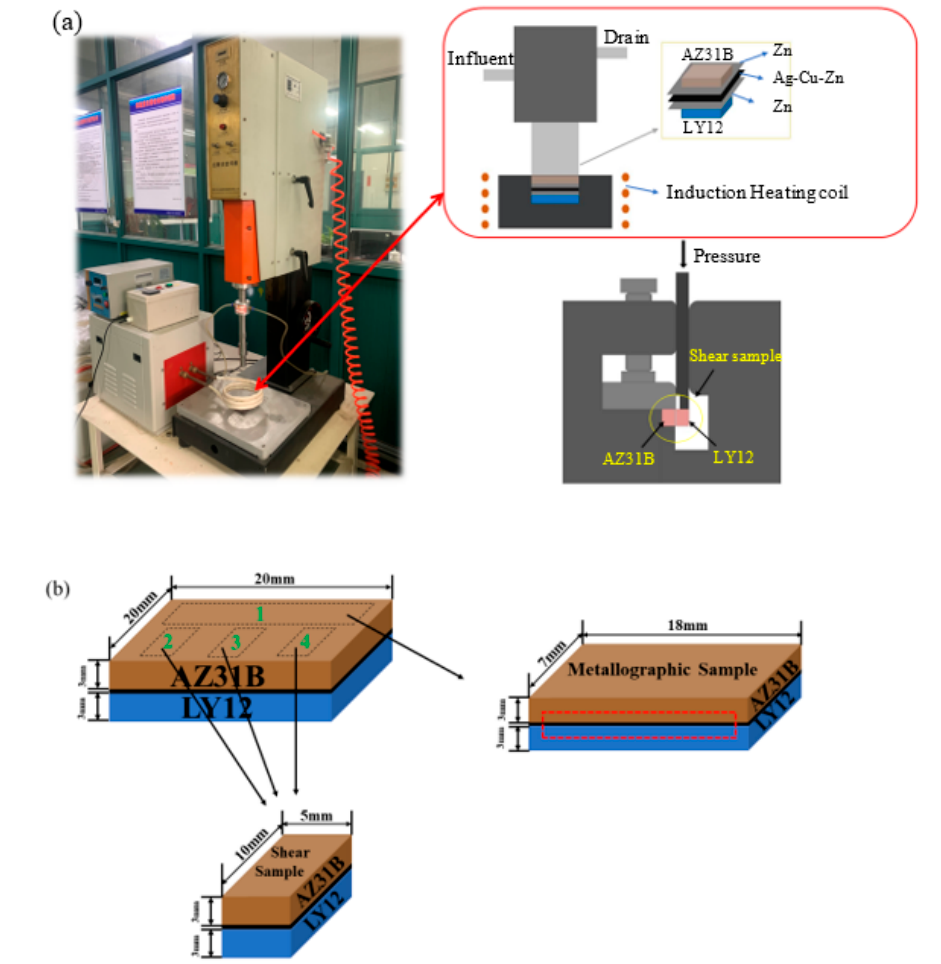
Figure 1. Schematic of U-TLP and the shear strength test device ( a ); Sampling schematic diagram of shear sample and metallographic sample ( b ).